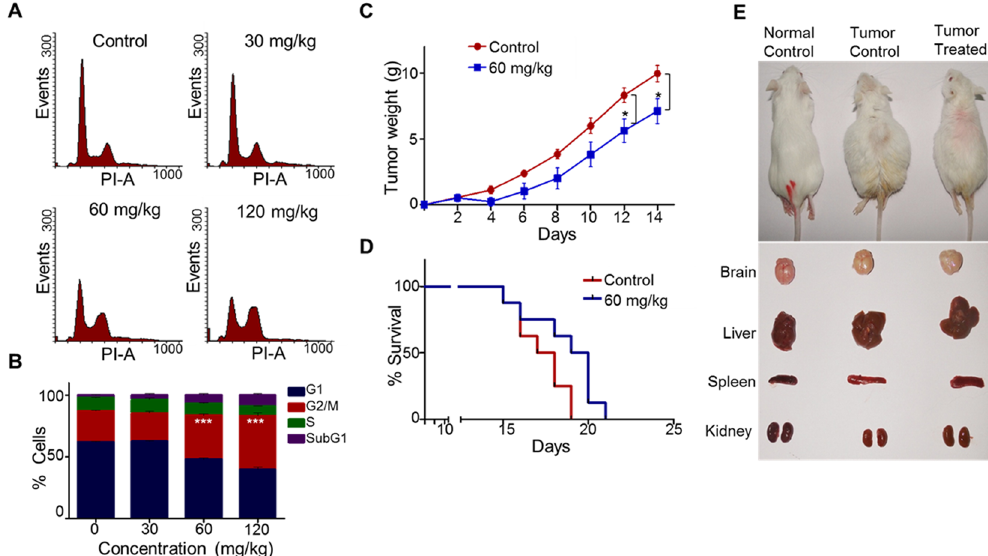
Figure 8. In vivo effect of 5 g on EAC tumor model. ( A , B ) EAC tumor cells from 5g-administered tumor mice were harvested and processed for cell cycle analysis. Histograms showing effect of 5g on cell cycle progression of EAC tumor cells in vivo (A). Quantification of different phases of cell cycle was carried out and presented as bar diagram (B) (n = 4). ( C – E ) Effect of 5g on tumor development was tested in EAC tumor model. Body weights of control and 5g (60 mg/kg; 14 doses; one dose/day) treated animals were measured, subtracted with initial body weight of respective animals and presented (n = 8) ( C ). ( D ) Survival graph showing improvement in lifespan after treating with 5g. ( E ) At 15 th day, single animal from each group was sacrificed and images were taken, examined for gross changes in organs like brain, liver, spleen and kidney. Statistical significance was calculated in G2/M population cells using student t-test and significance was shown if the p-value was equal to or less than